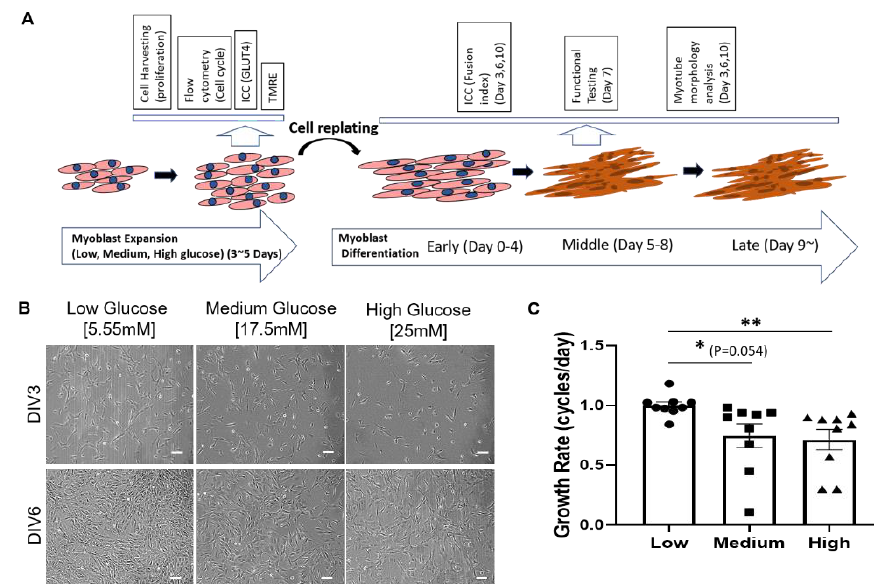
Figure 1. Effect of hyperglycemia on iPSC-derived myoblast proliferation. ( A ) Schematic illustration of iPSC-derived myoblast culturing and differentiation timeline, and the experiments at different stages. ( B ) Phase images of iPSC-derived myoblasts in 5 mM, 17.5 mM and 25 mM of glucose at days 3 (Days in vitro or DIV 3) and 6 (DIV 6) of proliferation. ( C ) Graph showing primary myoblasts proliferation rate in varying glucose concentration. Scale bar = 100 µ m. Error bar: SEM. p -value P ≤ 0.1, *; P ≤ 0.05, **; P ≤ 0.01, ***. n = 5 in 2 experiments. Statistics was performed utilizing One-way ANOVA with post-hoc Tukey HSD Test by comparing between each hyperglycemia group with the euglycemic control group.